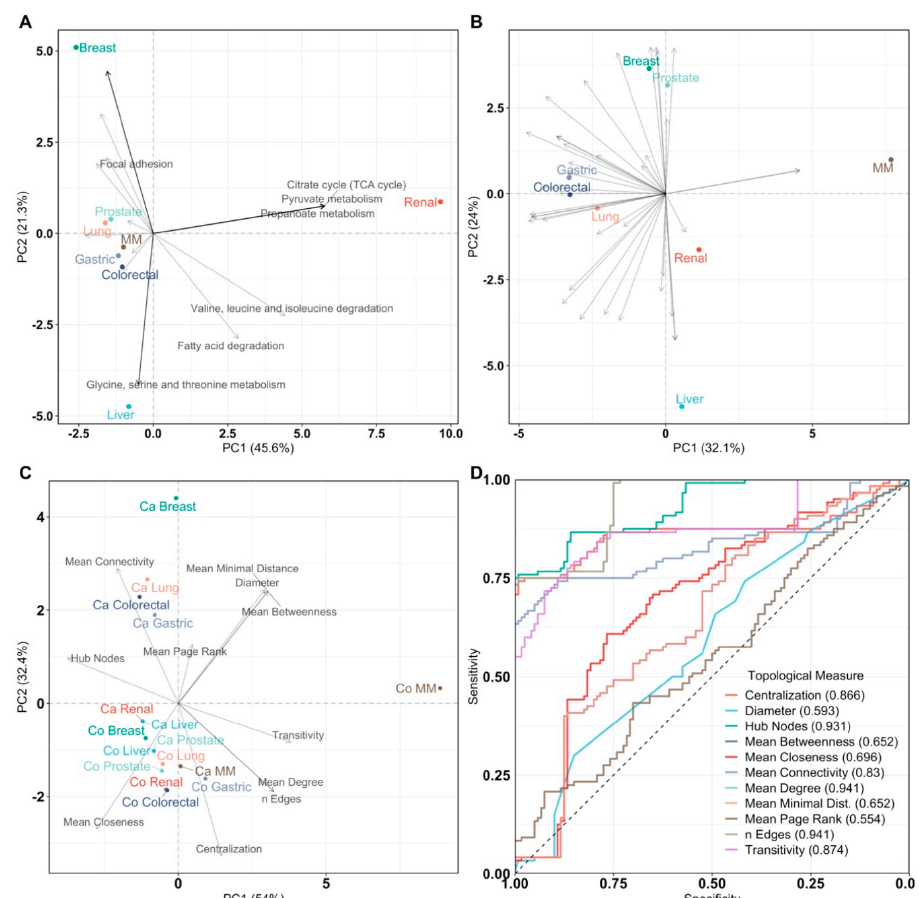
Figure 4. Principal Component Analysis of pathway impact and network analysis. PCA labels are colored according to their cancer type and PCA loadings are labeled if they have a pathway impact score > 0.5. Multiple myeloma is abbreviated as MM. ( A ) PCA biplot of pathway impact based on differentially abundant genes per cancer type; ( B ) PCA biplot of pathway impact based on differentially connected genes per cancer type; ( C ) PCA biplot of topological network measures per cancer type for all inferred gene networks. Here, networks inferred from cancer or control samples are labeled as “Ca” and “Co”, respectively; ( D ) receiver operating characteristic curves of topological measures predicting cancer pathology on gene association networks (n = 16, 8/8). Predictions are based on logistic regression, cross-validated with leave-one-out cross-validation. The Area Under the Curve (AUC), 95% confidence interval (CI), and p -value of all topological measures are Edges: AUC = 0.941, 95% CI = 0.915–0.967, p = 7.59 × 10 − 242 , Mean Connectivity: AUC = 0.830, 95% CI = 0.774–0.886, p = 8.80 × 10 − 31 , Mean Degree: AUC =0.941, 95% CI = 0.915–0.967, p = 7.59 × 10 − 242 , Mean Closeness: AUC = 0.696, 95% CI = 0.628–0.764, p = 1.85 × 10 − 8 , Mean Betweenness: AUC = 0.652, 95% CI = 0.582–0.722, p = 2.14 × 10 − 5 , Diameter: AUC = 0.593, 95% CI = 0.521–0.665, p = 0.0114, Mean Minimal Distance: AUC = 0.652, 95% CI = 0.582–0.722, p = 2.14 × 10 − 5 , Mean Page Rank: AUC = 0.554, 95% CI = 0.481–0.627, p = 0.146, Hub Nodes: AUC = 0.931, 95% CI = 0.902–0.961, p = 2.93 × 10 − 178 , Centralization: AUC = 0.866, 95% CI = 0.813–0.919, p = 8.00 × 10 − 42 , and Transitivity: AUC = 0.874, 95% CI = 0.828–0.92, p = 1.48 × 10 − 56 . Definitions of topological measures are given in